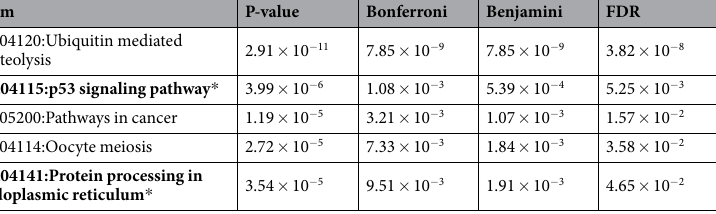
Table 3. Significant KEGG pathways corresponding to target union from miR-210 and miR-30c, with all of the Bonferroni, Benjamini and FDR values smaller than 0.05. * Bold pathways correspond to significant pathways which are insignificant using targets from either miR-210 or miR-30c.